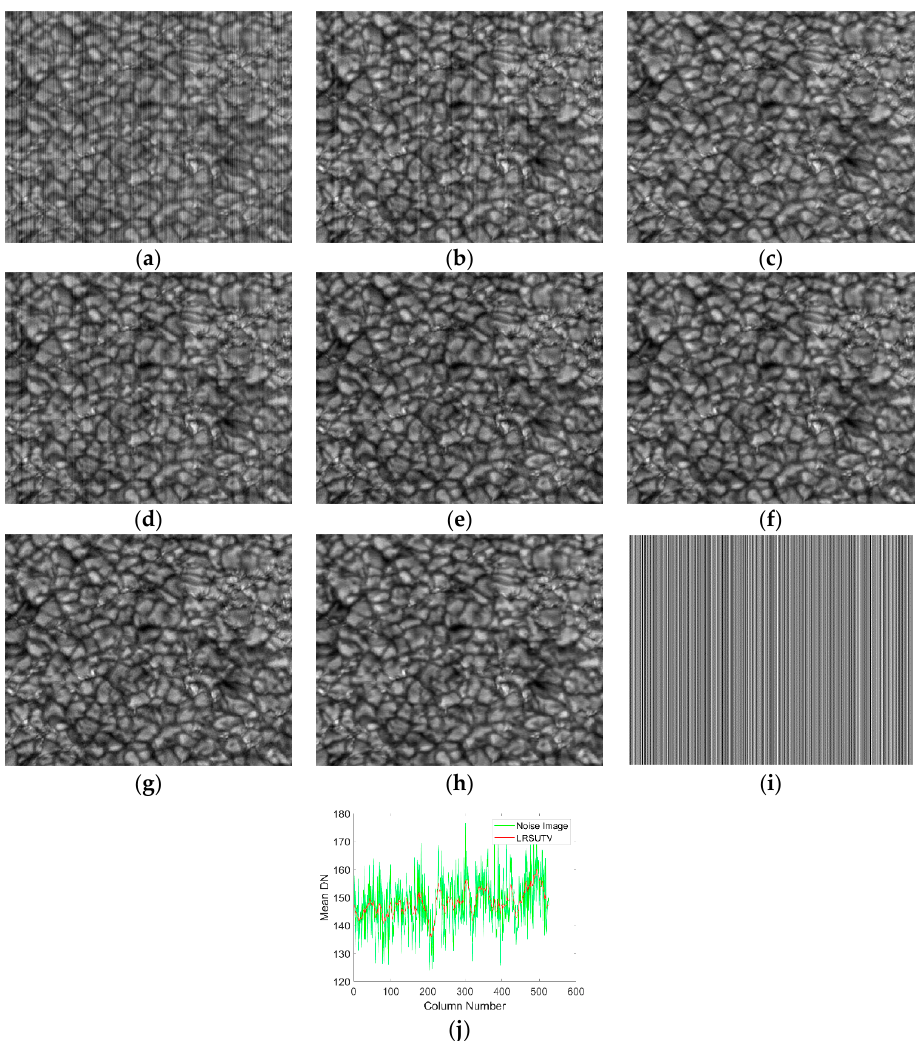
Figure 17. Denoising effect of various methods in the area of solar granular. ( a ) Noise Image; ( b ) WAFT; ( c ) UTV; ( d ) ASSTV; ( e ) VSNR; ( f ) SILR; ( g ) ℓ (cid:2868) sparse; ( h ) LRSUTV; ( i ) CFPN noise estimated by LRSUTV method; ( j ) mean cross track of images ( a ) and ( h ).